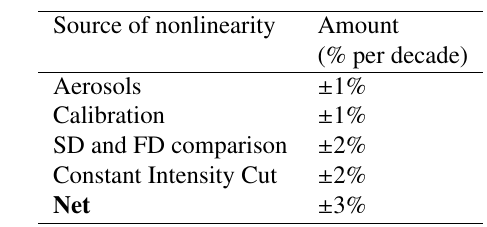
Table 2. Sources of energy-dependent reconstruction bias